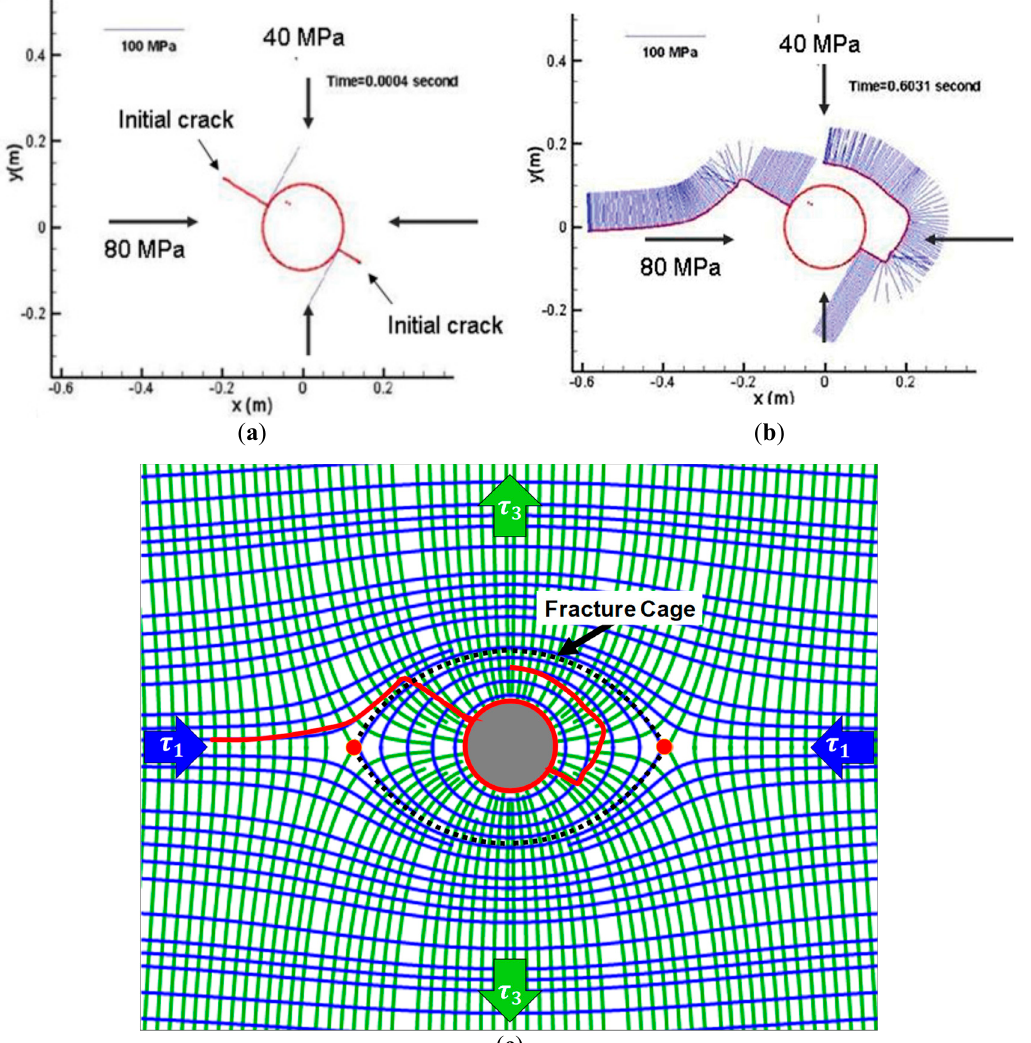
Figure 14. Comparison of the stress trajectories with the numerical simulation results when maximum and minimum total principal stresses normal to the wellbore are 80 MPa and 40 MPa, respectively [2]. Two initial cracks are placed at the wellbore wall with the length of 0.64 (right fracture) and 1.28 times (left fracture) the wellbore radius. The dimensionless variables χ and F are –0.5 and –1.66, respectively. The results are ( a ) at time 0.0004 and ( b ) 0.6031 second. ( c ) The numerical fracture propagation result and the analytical stress trajectory contours are overlaid and match closely.